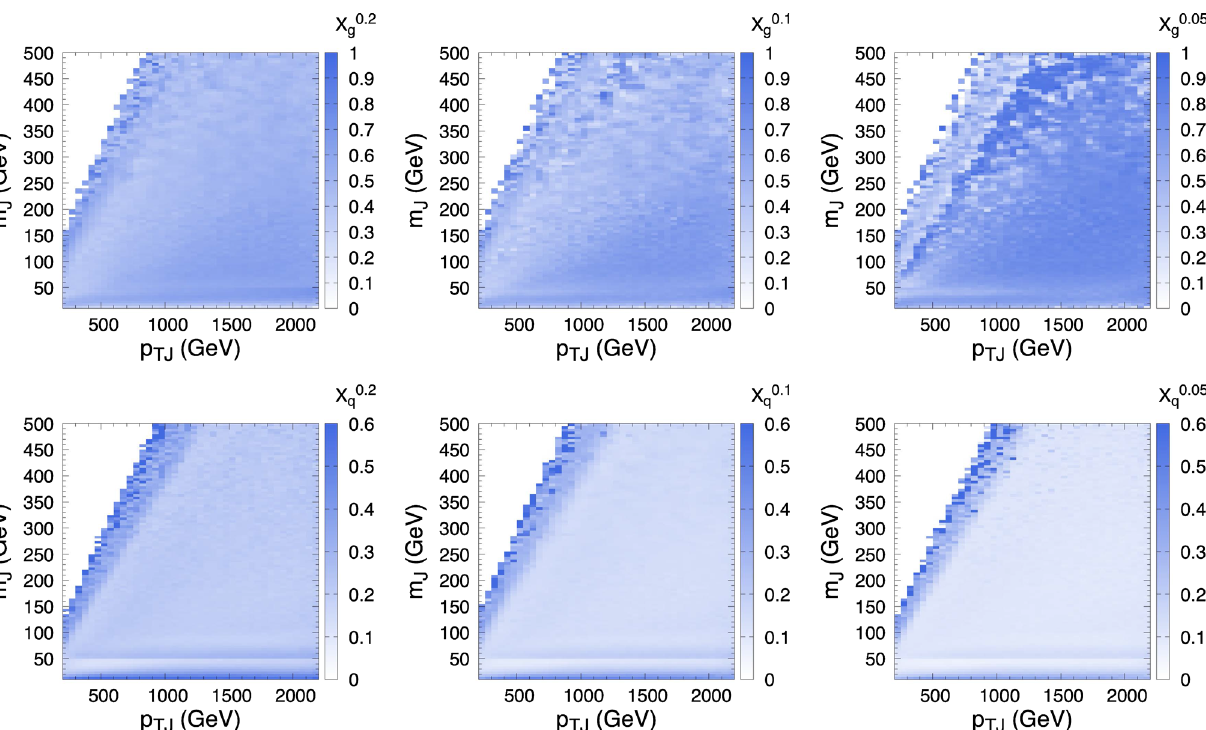
Fig. 5 Thresholds for exclusive mass decorrelation computed in bins of jet mass and p T for three fixed efficiencies ε b = 0 . 2, 0.1, 0.05 from left to right. Empty bins on the upper left side of the plots are shown in white